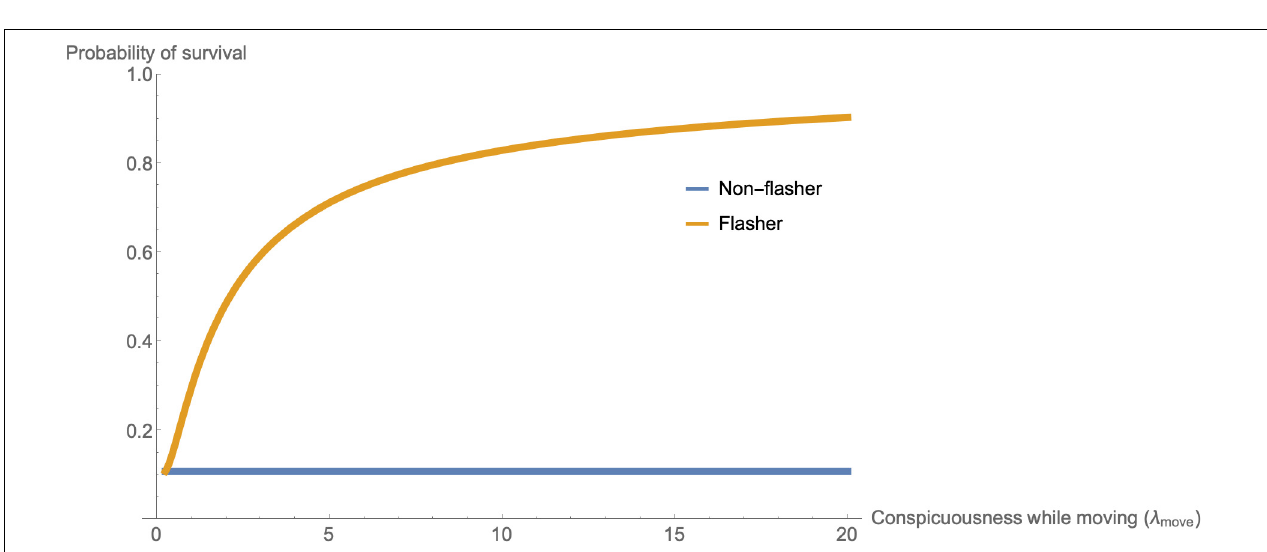
FIGURE 4 | The survival rate of a non-flashing cryptic species (blue) that has the same appearance when moving as it does at rest ( λ move = λ rest ) compared with the survival rate of a flashing species that gives the false impression of being more conspicuous when it seen moving than it is once settled ( λ move > λ rest ). Here the apparent conspicuousness of the fleeing prey ( λ move ) influences the time the predator spends searching for prey. In general, the higher the conspicuousness of the flashing prey while fleeing ( x -axis) the greater its survivorship advantage over non-flashing prey because the lower the maximum amount of time predators